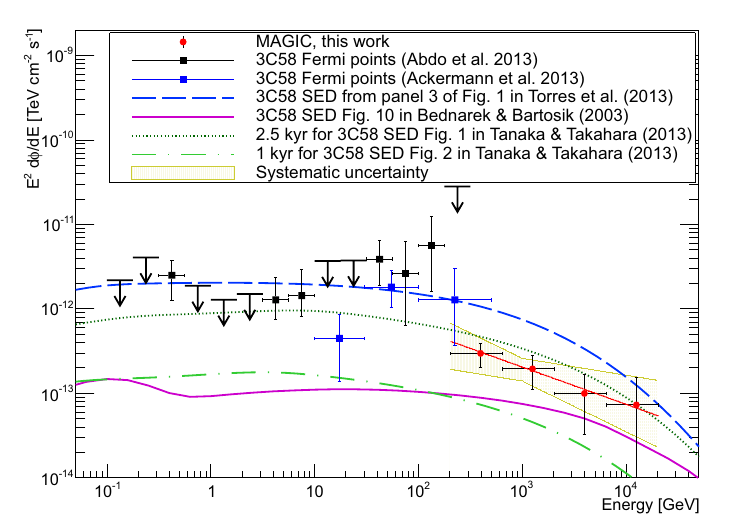
Figure 5. 3C 58 spectral energy distribution in the range between 0.1 GeV and 20TeV. Red circles are the VHE points reported in this work. The best-fit function is drawn in red and the systematic uncertainty is represented by the yellow shaded area. Black squares and arrows are taken from the Fermi-LAT second pulsar catalog. Blue squares are taken from the Fermi-LAT high-energy catalog. The magenta, clear green dashed-dotted, dark green and blue dashed lines correspond to different models of the source. See [9] for details.